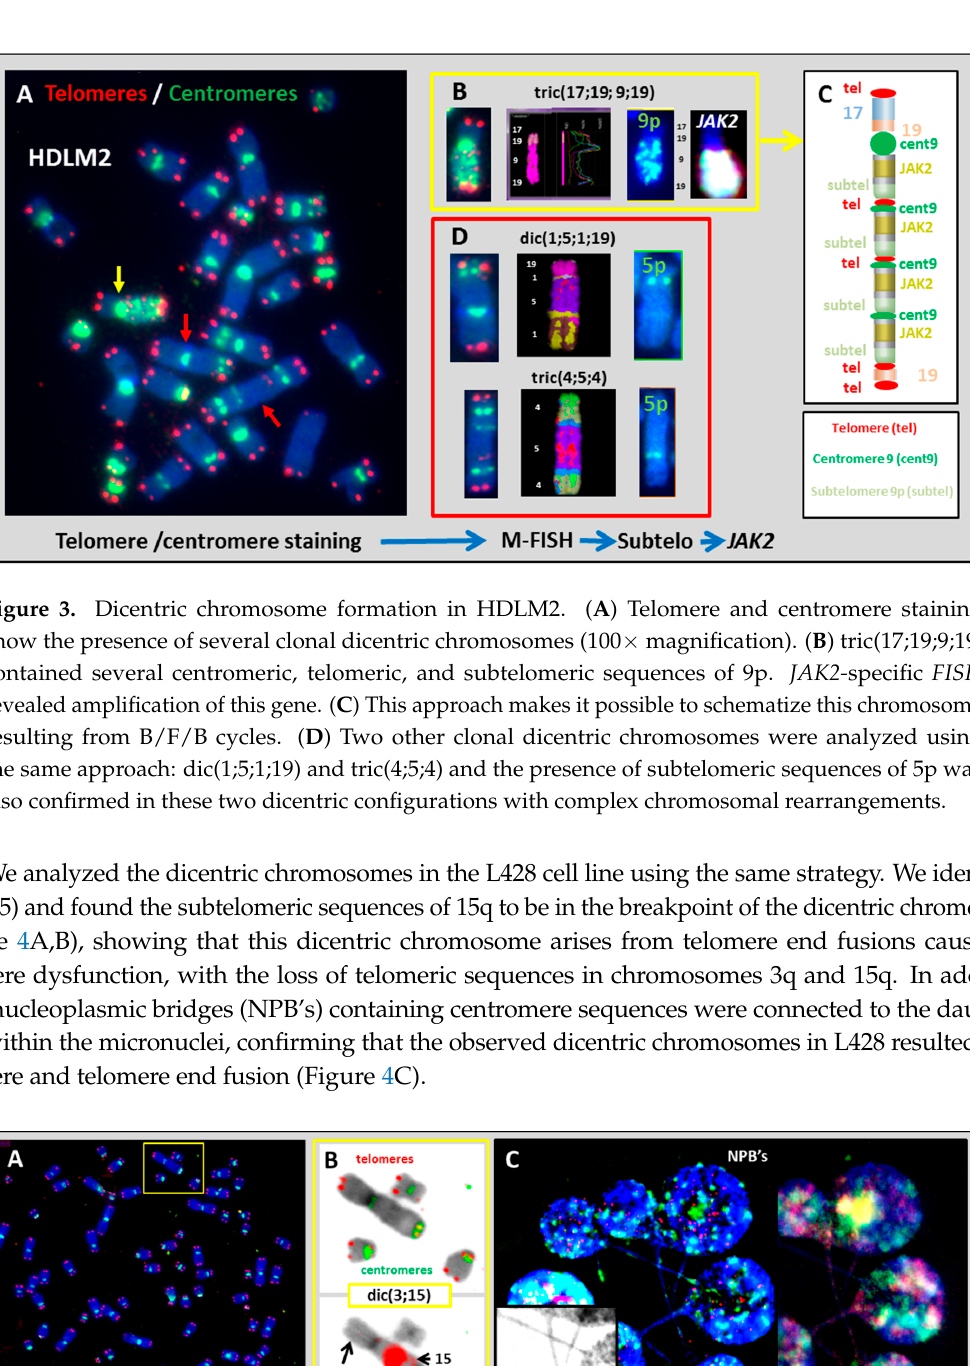
Figure 5. Breakpoints in clonal dicentric chromosomes in L1236 cells by sequential analysis using ( A ) telomere and centromere staining followed by ( B ) M-FISH staining and ( C ) classification of chromosomes. ( D ) Pericentromeric breakpoints detected in clonal dicentric chromosomes (63× magnification). Clonal dicentric chromosomes in KMH2 cells were characterized by a specific configuration with the pericentrometric breakpoints and the two centromeres in close proximity (Figure 6). In addition, the presence of small NPB’s, associated with micronuclei containing telomeric sequences only, originating from the acentric chromosome (Figures S4–S8), were observed in these cell lines (Figure 7A,B). Of note, we observed high expression of 53BP1 protein in the L1236 and KMH2 cell lines (Figure 7C), in which we found intra-chromosomal γ H2AX foci (Figure 7D).